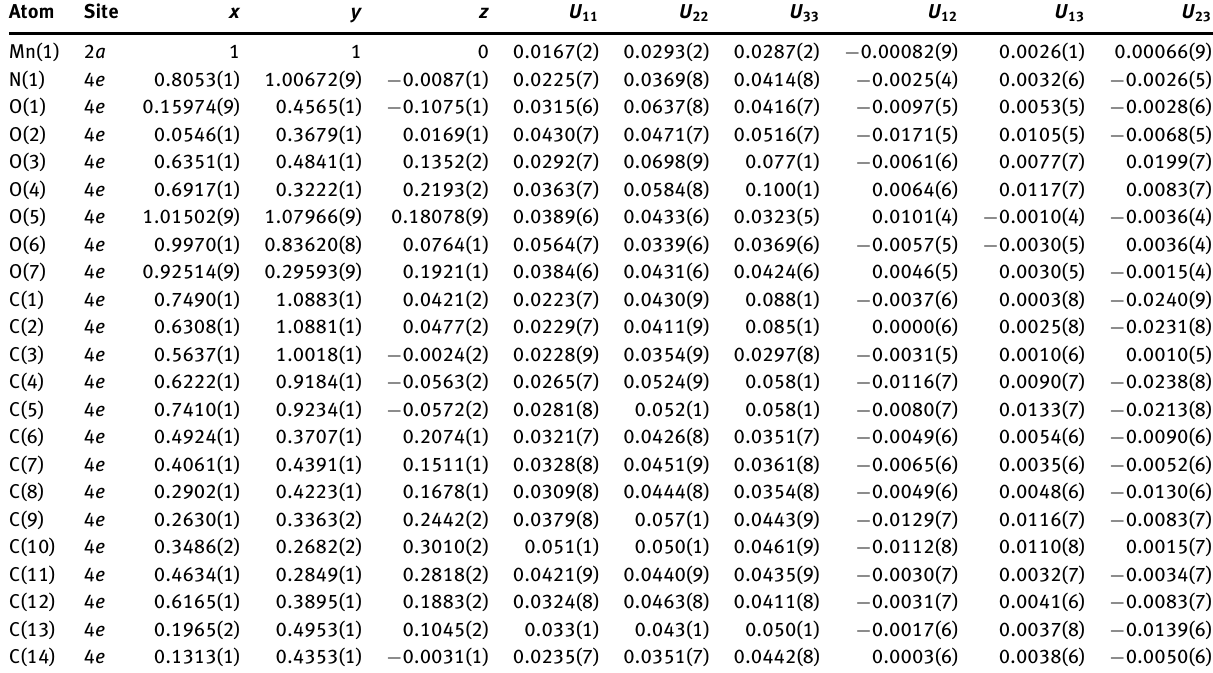
Table 3: Atomic coordinates and displacement parameters (in Å 2